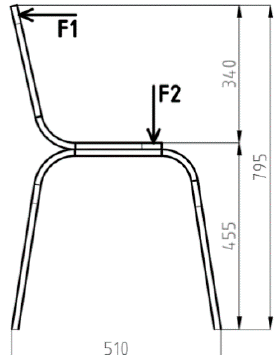
Figure 3. Static loading of the chair according to the standard EN 1728:2012 + dimensions of the designed chair.